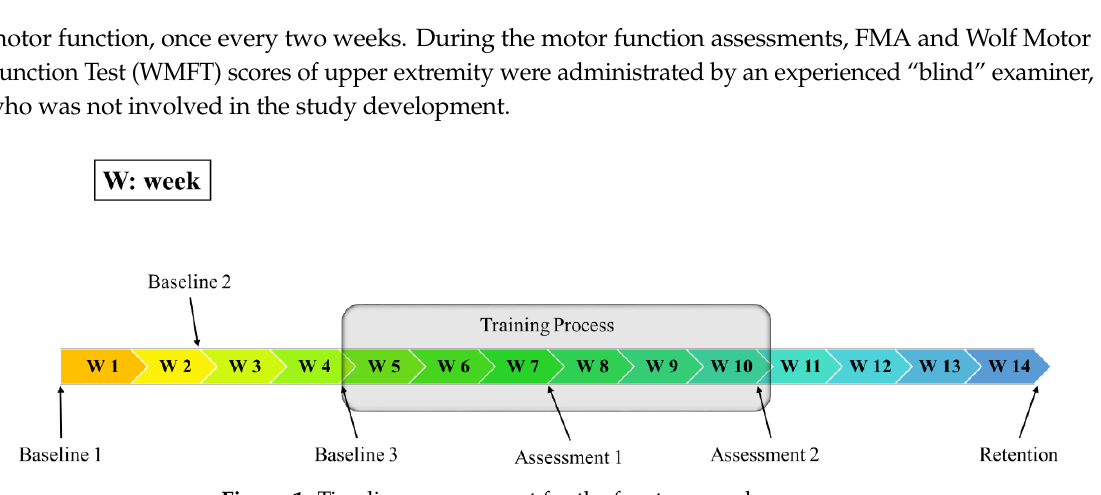
Figure 1. Timeline arrangement for the fourteen-week program.